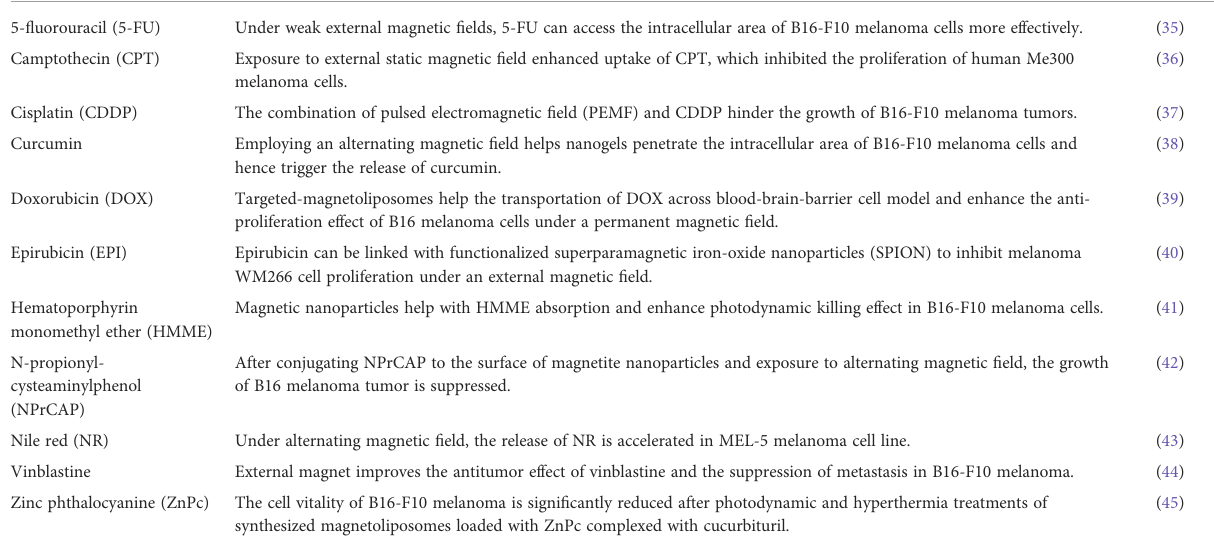
TABLE 2 EMF ’ s impact on drug uptake: listed in alphabetical order.